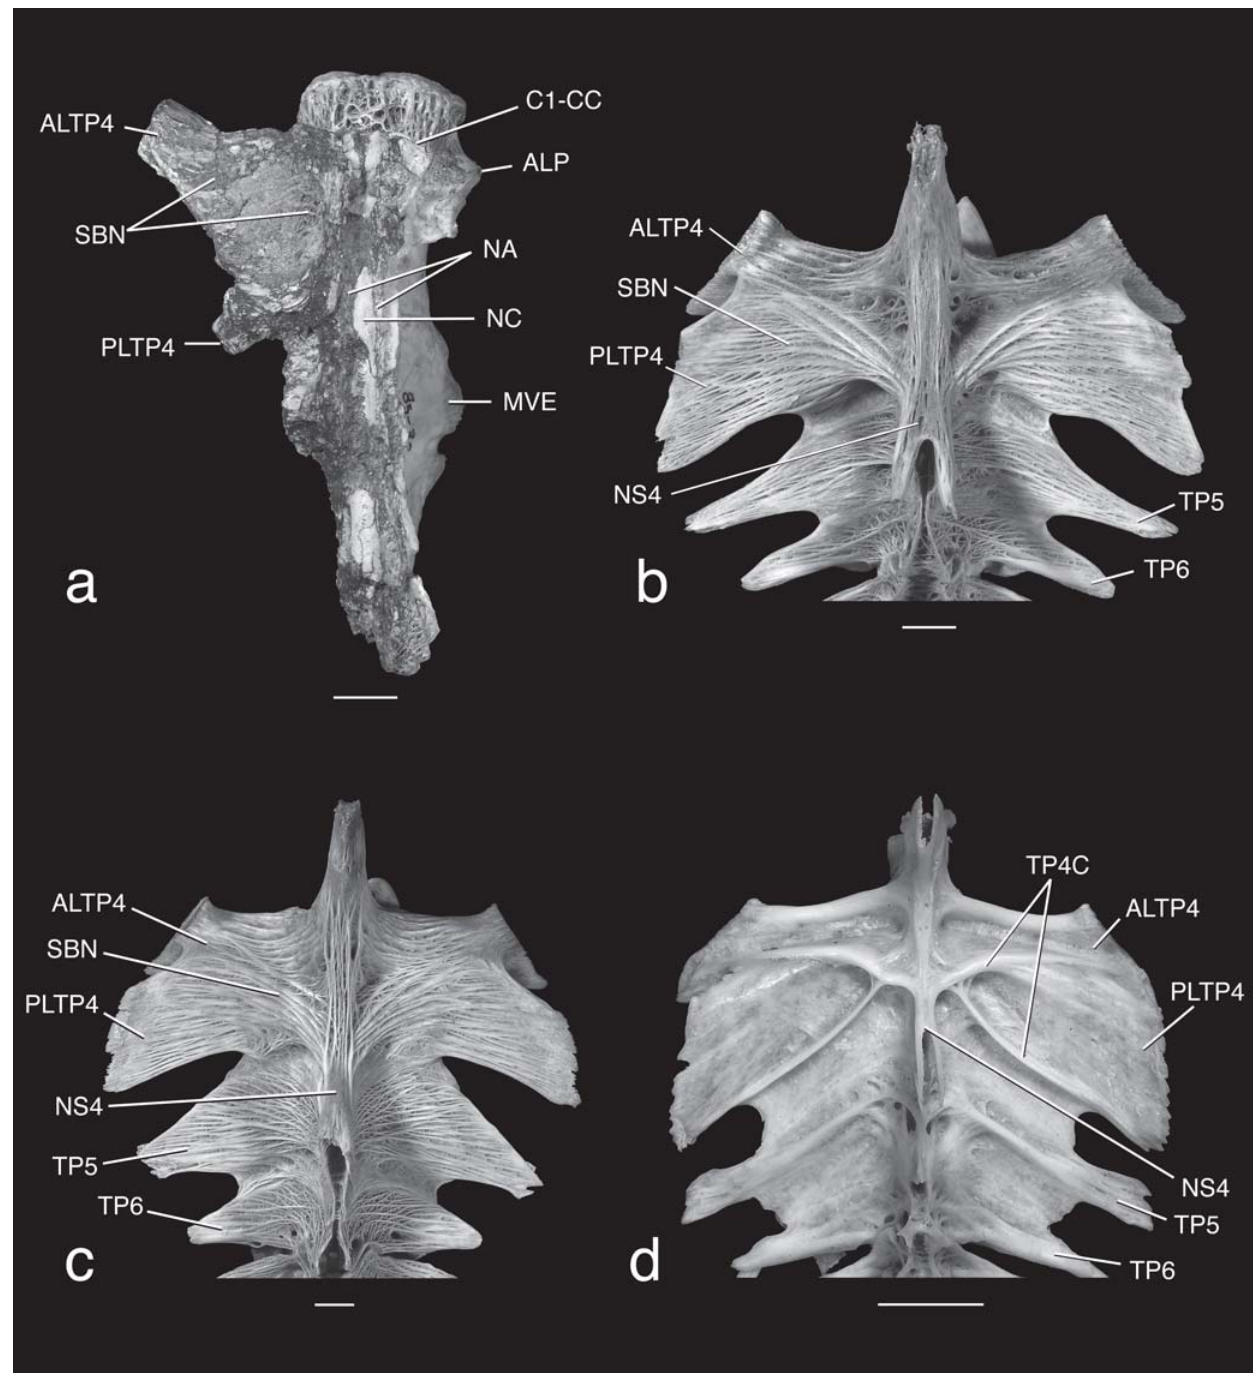
Fig. 1. Weberian complexes in dorsal view of the fossil and modern Brachyplatystoma species, a, B. promagdalena , IGM183062, b, B. filamentosum , DU F1052, from the río Apure, Venezuela ; c, B. rousseauxii , DU F1078, from the río Apure, Venezuela ; d, B. vaillantii , DU F1034, from the río Apure, Venezuela. Scale bars equal to 1 cm. Abbreviations: ALP, anterolateral processes; ALTP4, anterior limb of fourth transverse process; C1-CC, First centrum-compound centrum joint; MVE, midventral expansion on fifth centrum; NA, neural arch; NC, neural canal; NS4, neural spine of fourth vertebra; PLTP4, posterior limb of fourth transverse process; SBN, spongy bone, TP4C, crests on fourth transverse process, TP5, fifth transverse process; TP6, sixth transverse